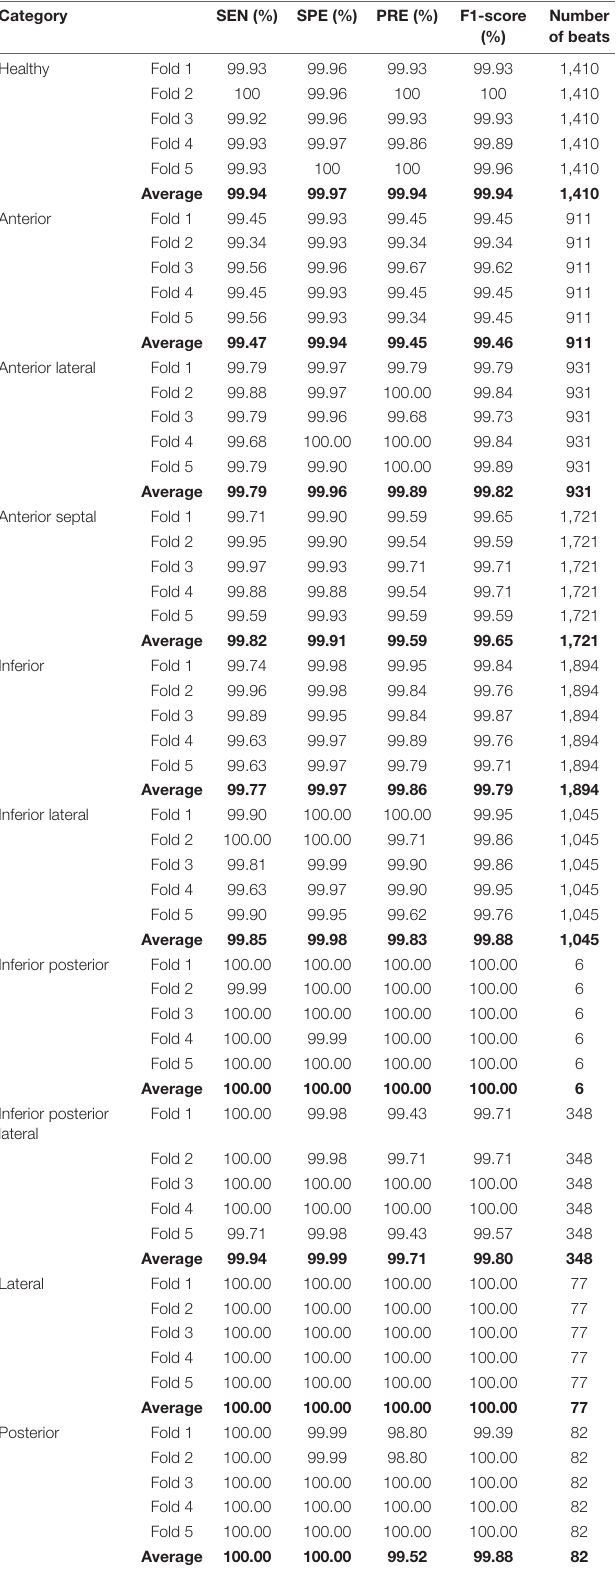
TABLE 4 | Classification performance of MI localization (five-fold cross validation). Category Number